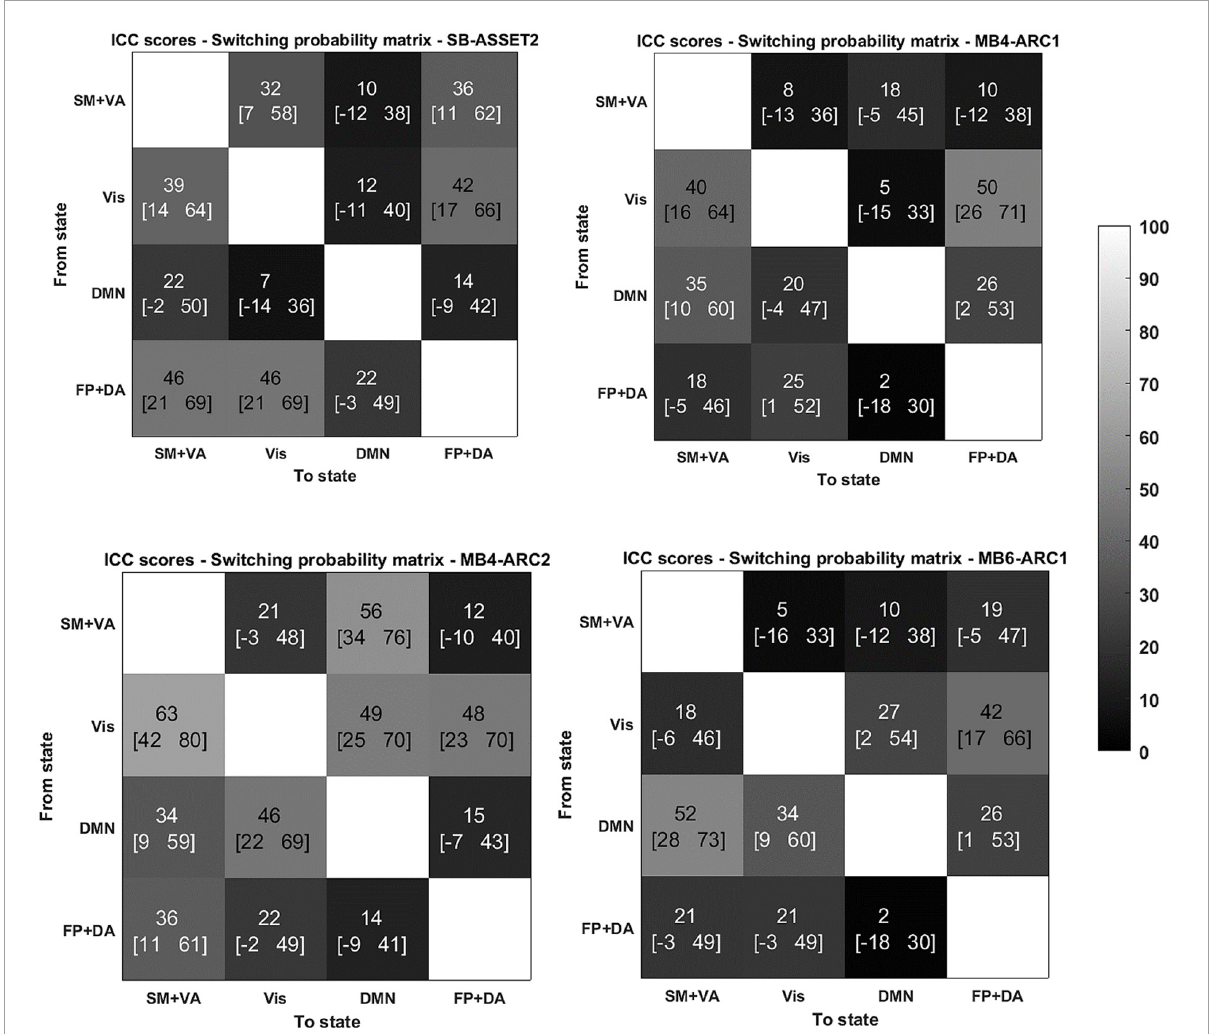
FIGURE3 Reliability of switching probabilities between states for the 4 modalities. ICC scores (lower bound of the 95% confidence interval- upper bound of the 95% confidence interval) for the switching probability measure from and to each of the states for SB-ASSET2, MB4-ARC1, MB4- ARC2, and MB6-ARC1; color-coded based on Landis and Koch (1977)’s ICC categorization: poor in blue, fair in green, moderate in orange, substantial in red, and almost perfect in brown. SM, somato-motor network; VA, ventral attention network; FP, frontoparietal network; DA, dorsal attention network; Vis, visual